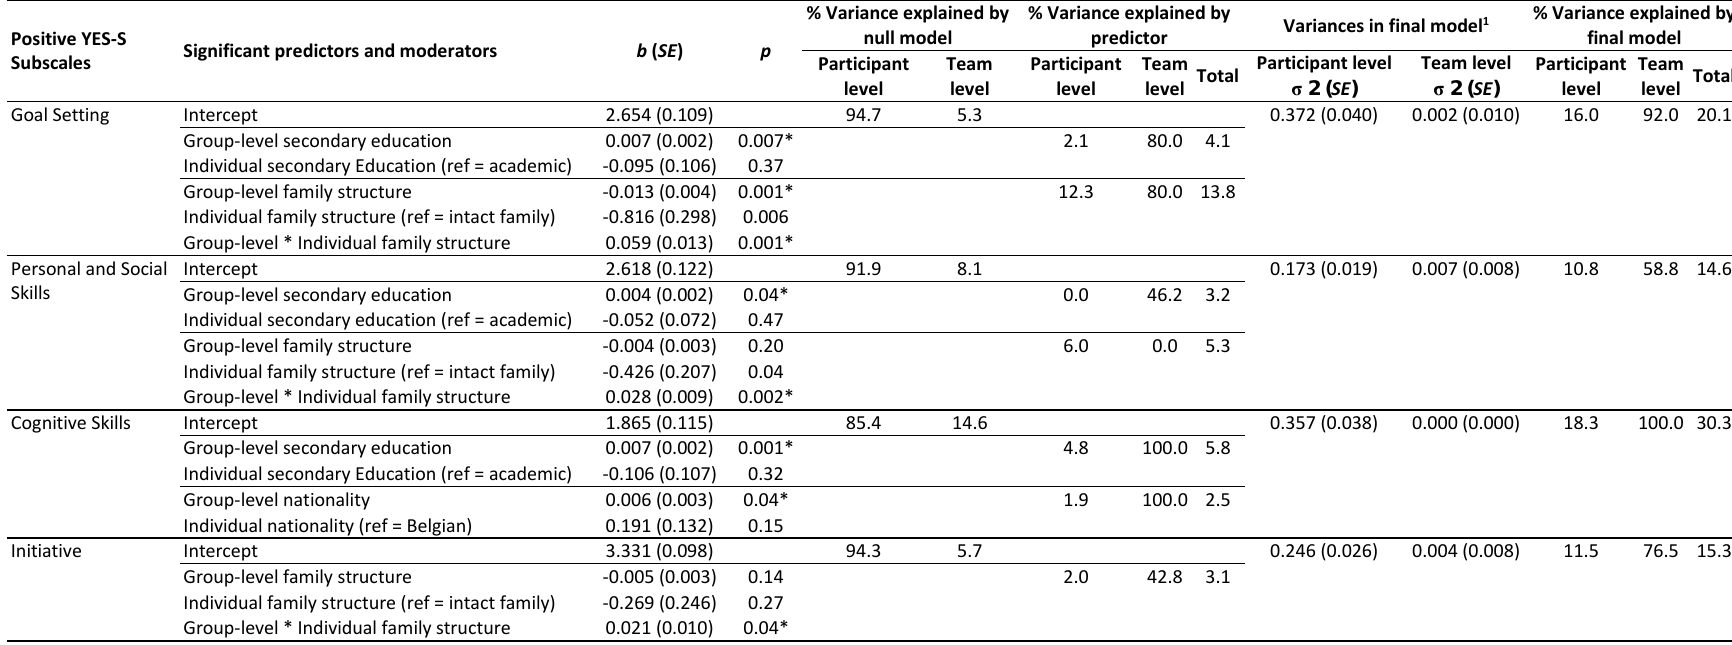
Table 3. Results of the regression model predicting positive developmental